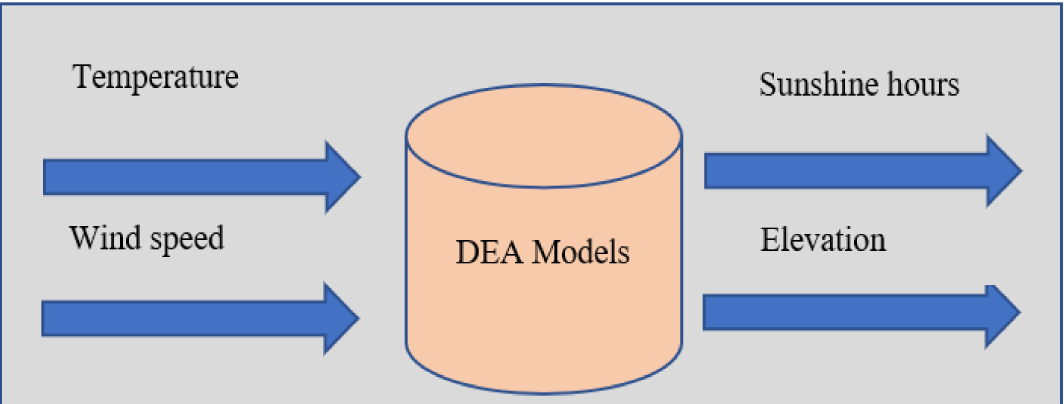
Figure 7. Inputs and outputs of DEA models.